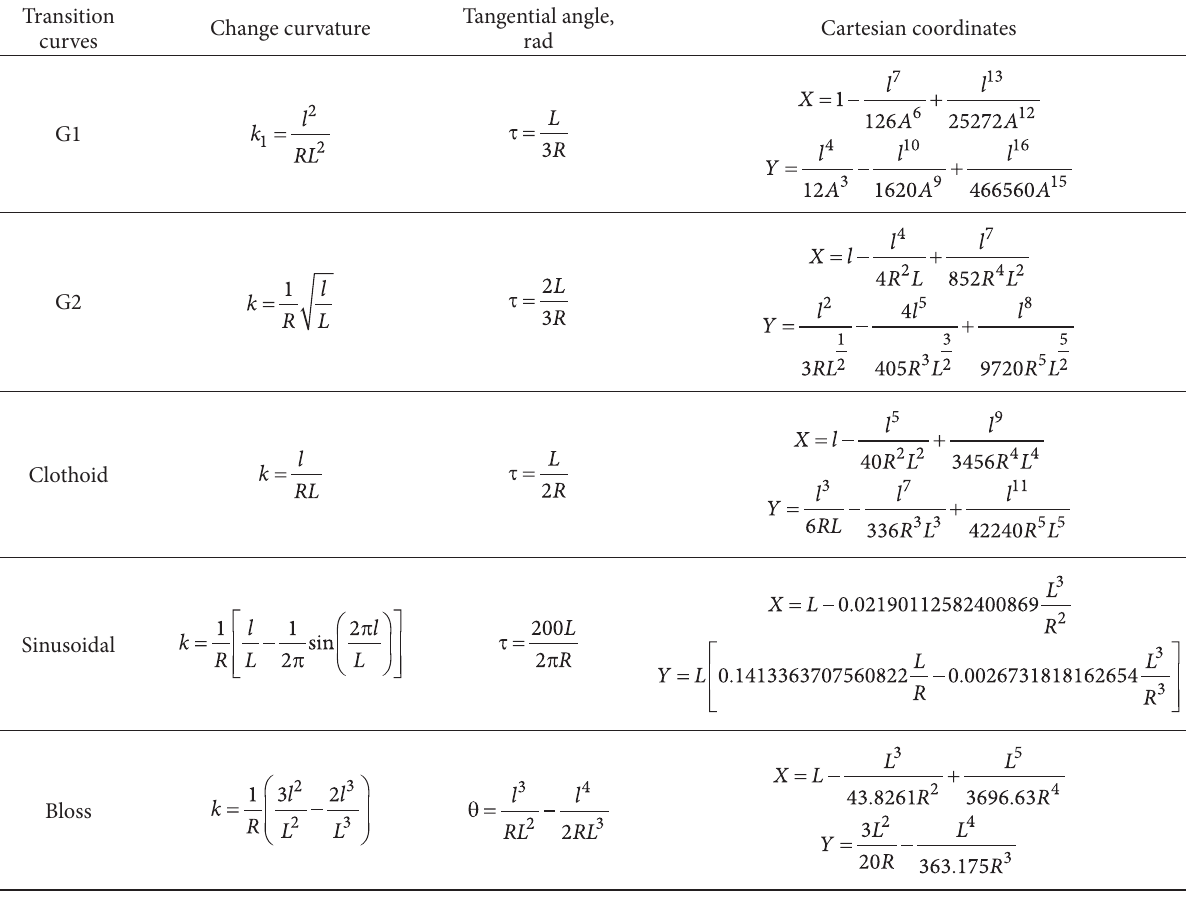
Table 1. Comparison parameters 1